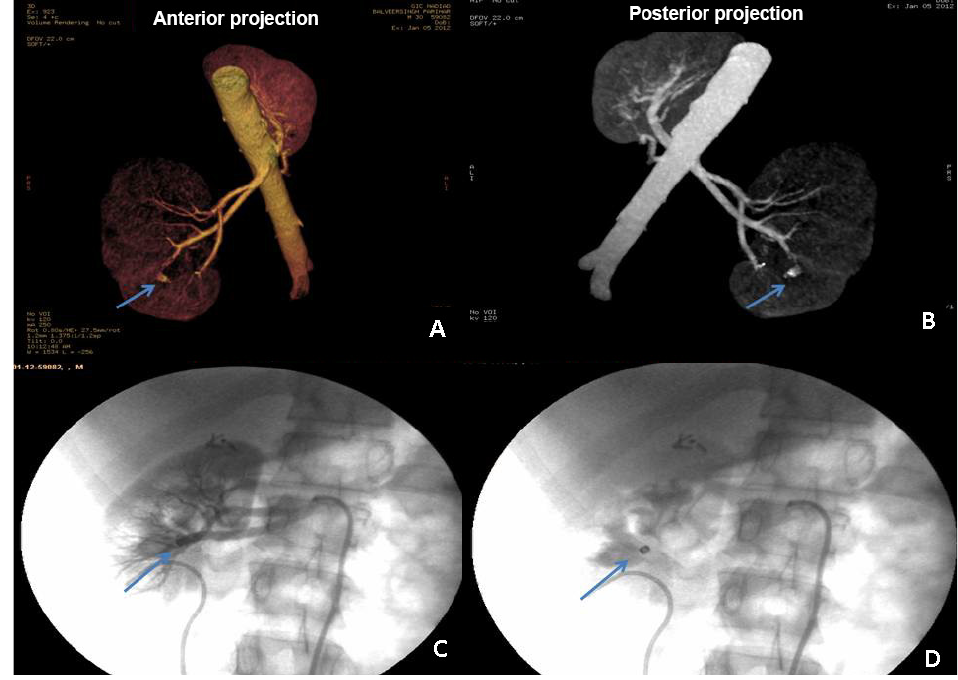
Figure 1. Case 1. a ) Aneurysmal dilatation seen on MDCT in a branch of the posterior segmental artery (anterior projection; arrow). b ) The same lesion seen on posterior projection (arrow). c and d ) A platinum coil used for embolisation (arrows).